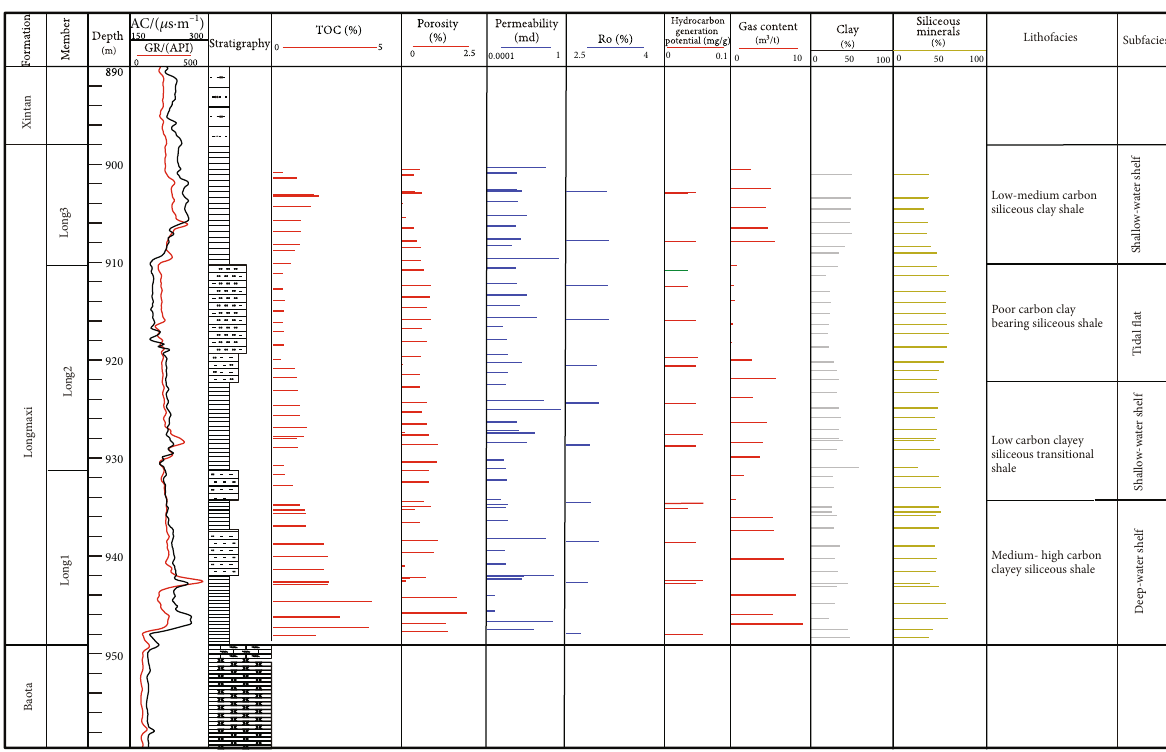
Figure 2: Comprehensive column of the Longmaxi Formation in well Laidi 1 in the Laifeng-Xianfeng block, Hubei